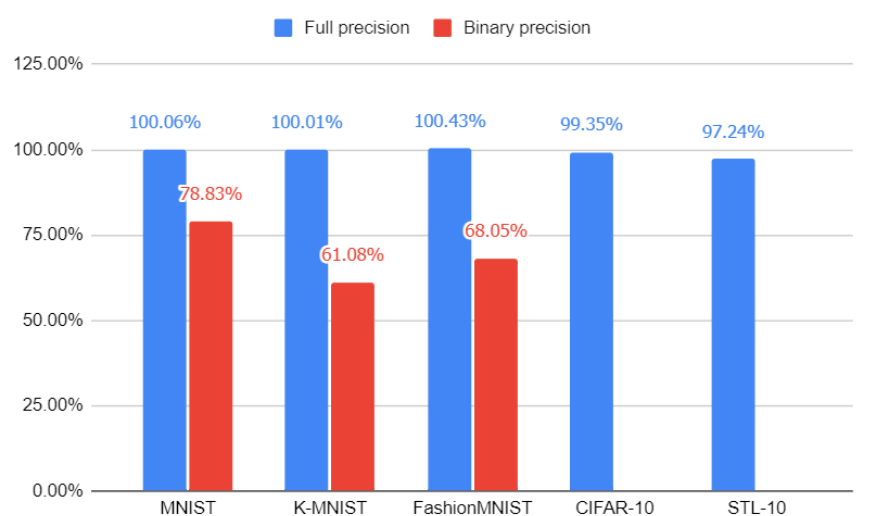
Figure 11. Correct Rate Performance Ratio of MLUTNet and